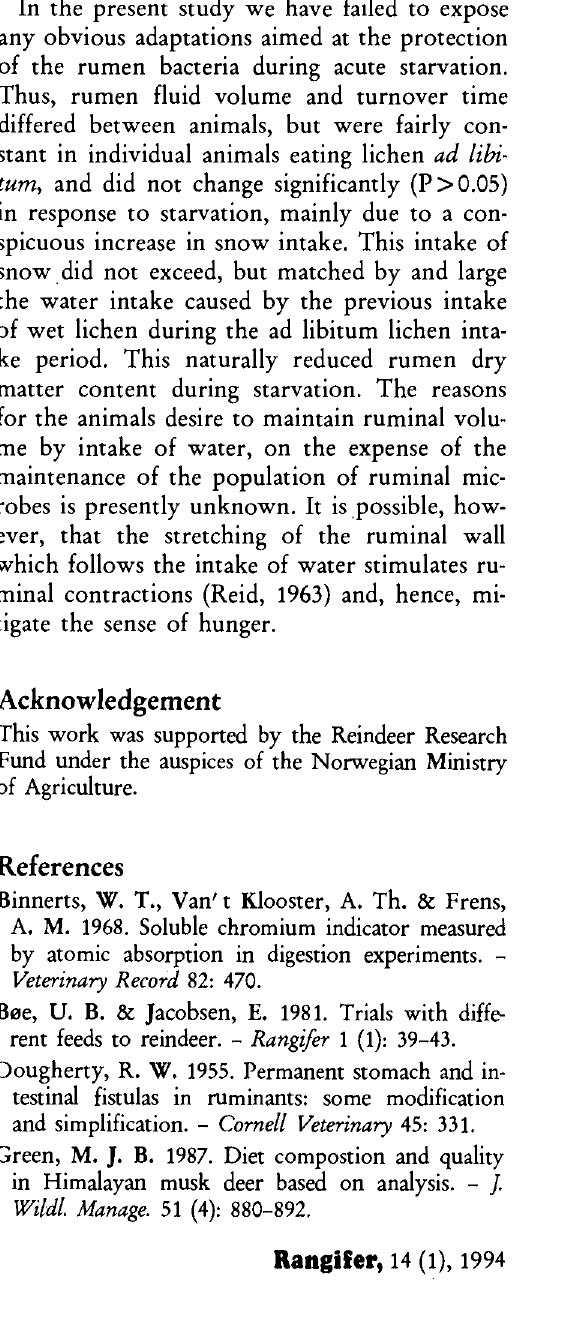
Fig. 1. Body mass, daily lichen (dry matter) and snoe in take of four reindeer fed lichen ad libitum (day 1-14) and during 4 days of starvation (day